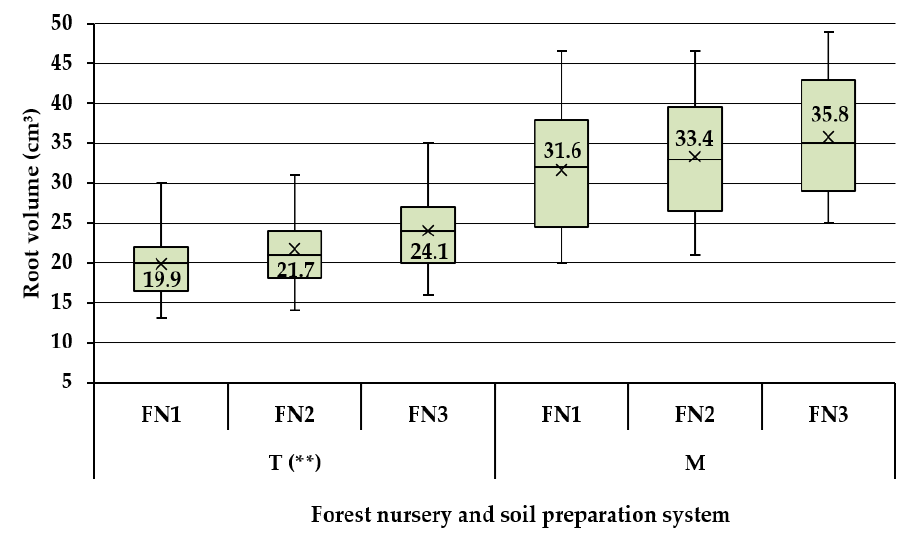
Figure 4. Descriptive statistics and results of the statistical comparison of root’s volume at the seedbed tillage system level. Legend: T—traditional seedbed tillage system, M—minimal seedbed tillage system, FN1—forest nursery of Iarac, FN2—forest nursery of Agri ş ul Mare, FN3—forest nursery of Ios ăş el. Note: diagnose indicated by ** stands for p values in the range of 0.01 to 0.001.